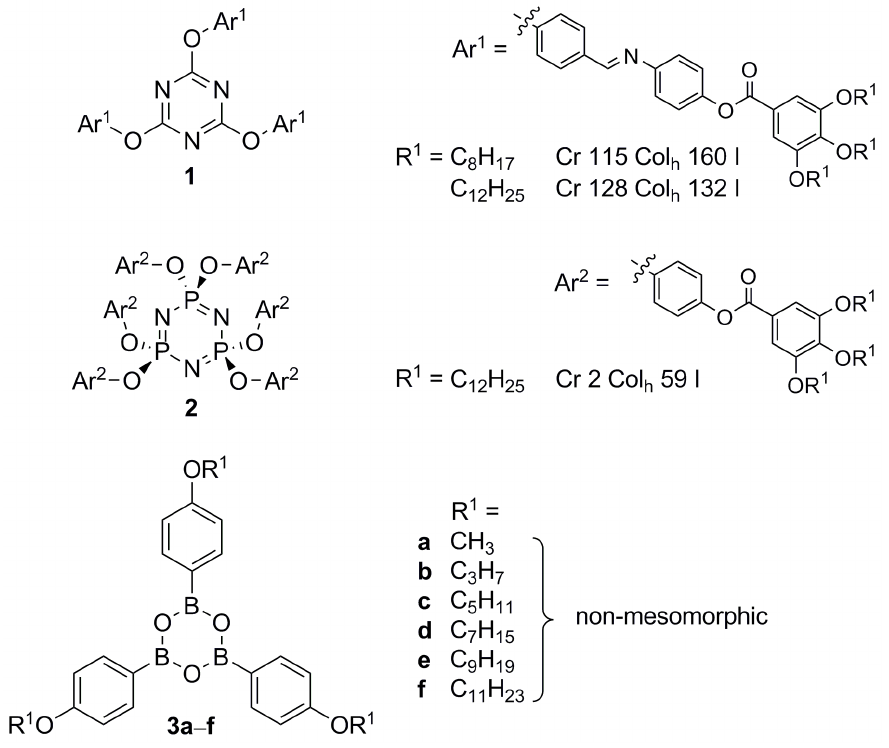
Figure 1. Chemical structure of liquid crystals (LC) materials containing a heterocyclic six-membered ring as core